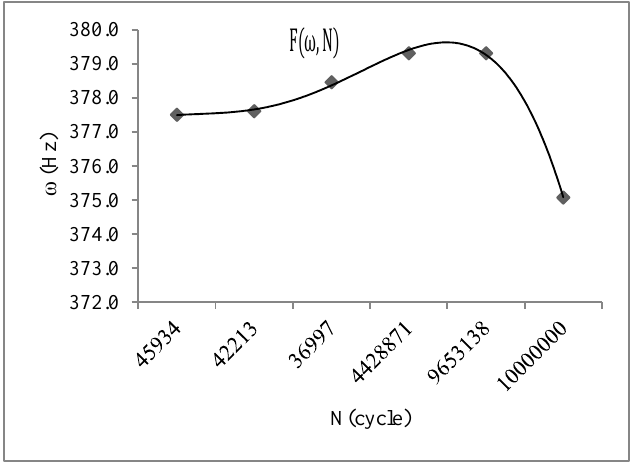
Figure 7. Vibration frequency – fatigue life of aluminium alloy 7050.